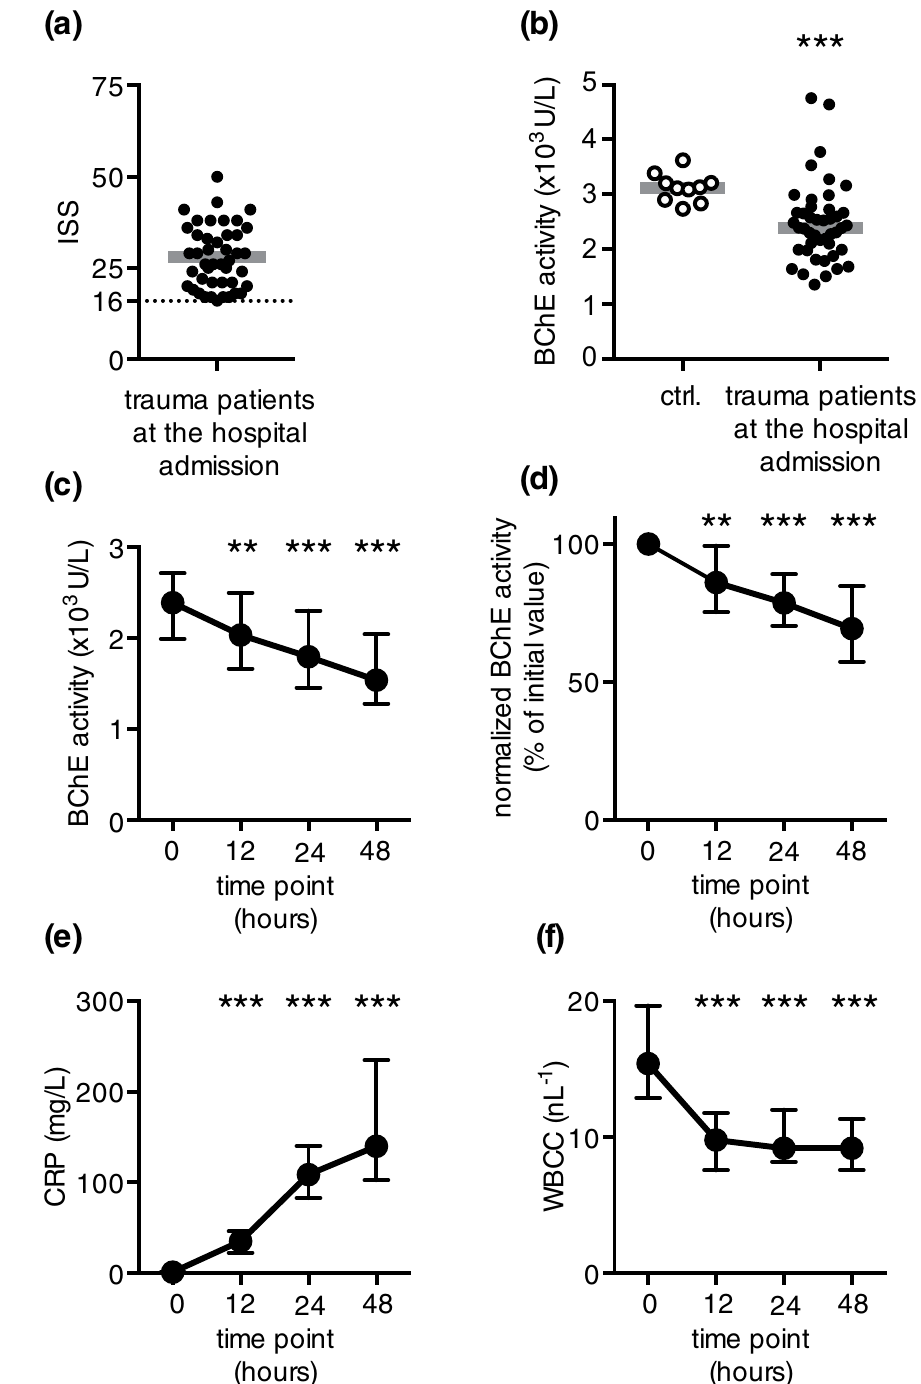
Figure 1. An immediate and sustained reduction in BChE activity occurs following major traumatic injury. (a) Scatter plot represents ISS scores obtained from trauma patients upon arrival to the emergency department (b) Data points represent BChE activity measured from 10 healthy volunteers (ctrl., open circles) and 44 major trauma patients at the hospital admission (closed circles). ( c ) The activity of BChE measured in injured patients 12, 24 and 48 hours following hospital admission significantly decreased, when compared to the initial measurement at hospital admission. ( d ) BChE activity data shown in ( c ), normalized to the initial value obtained at hospital admission. ( e ) Concurrent measurement of CRP activity revealed a continuous increase starting 12 h after hospital admission. ( f ) The initial elevation in WBCC decreased 12 hours later and remained constant throughout the observation period. Grey lines in ( a,b ) are medians. Error bars are interquartile range. ** p < 0.01; *** p < 0.001 (Friedman test followed by Dunn’s multiple comparisons test); ISS – Injury Severity Score; ctrl. – control (healthy volunteers); CRP – C-reactive protein; WBCC – white blood cell